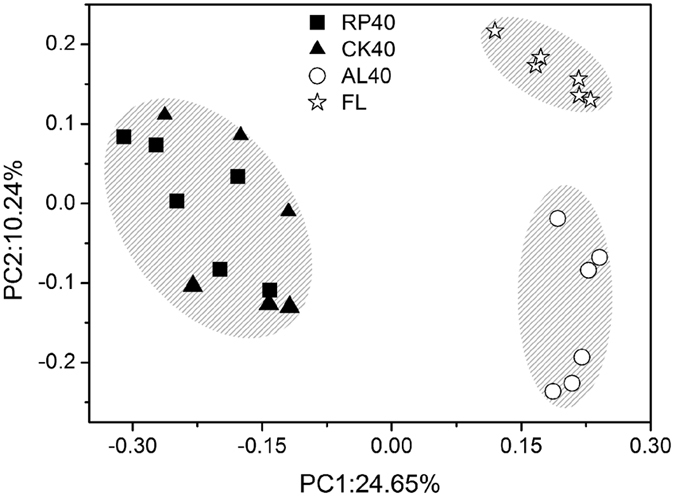
Unweighted-Unifracted PcoA of soil bacterial communities following afforestation.